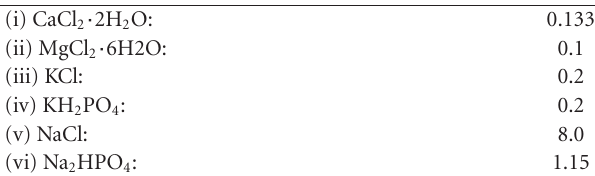
Table 1: Chemical composition of Biodentine, Septodont, St Maure des Foss´es, France.